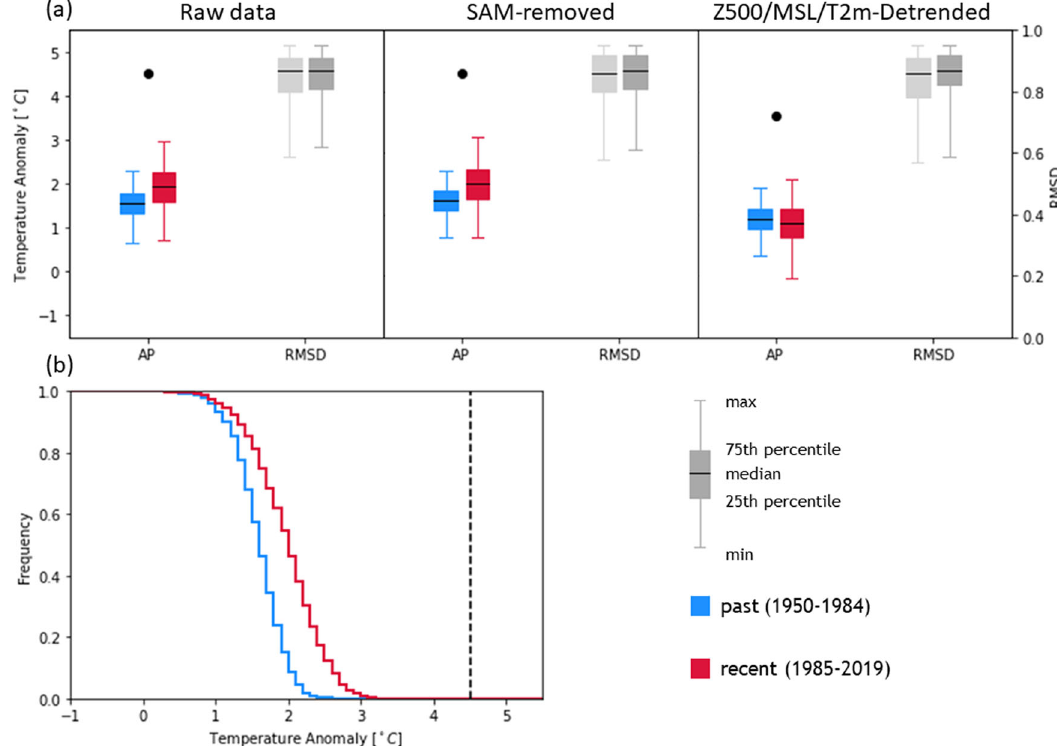
Fig. 4 Analog analysis of the 6 – 11 February 2020 heatwave. a Flow-conditioned distributions of 6-day mean AP T2m anomaly (colored whiskers; °C wrt. 1950 – 2019 in left y-axis) and normalized AN Z500/MSLP RMSD (grey whiskers; gpm in right y-axis) as reconstructed from analogs of the 2020 AP heatwave (6 – 11 February 2020). Blue and light grey whiskers show the distributions from past (1950 – 1984) analogs, while red and dark grey whiskers correspond to the recent sub-period (1985 – 2019). Left, central and right insets in ( a ) show the distributions obtained from the raw data, SAM-removed data, and detrended data respectively. Boxes denote the 25 th – 75 th percentile ranges and whiskers span the 1 st – 99 th percentiles. Black dot indicates the 6 – 11 February 2020 mean T2m anomaly in the AP region. b Cumulative distribution function with the relative frequency of past (blue) and recent (red) analogs displaying 6-day mean anomalies of AP T2m above a given threshold (x-axis). Data source: ERA5